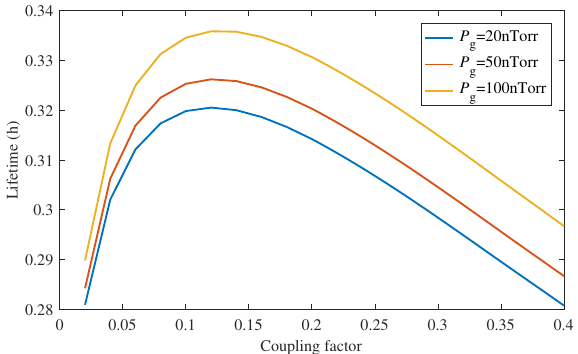
FIG. 24. Touschek lifetime under different gas pressure and varying coupling